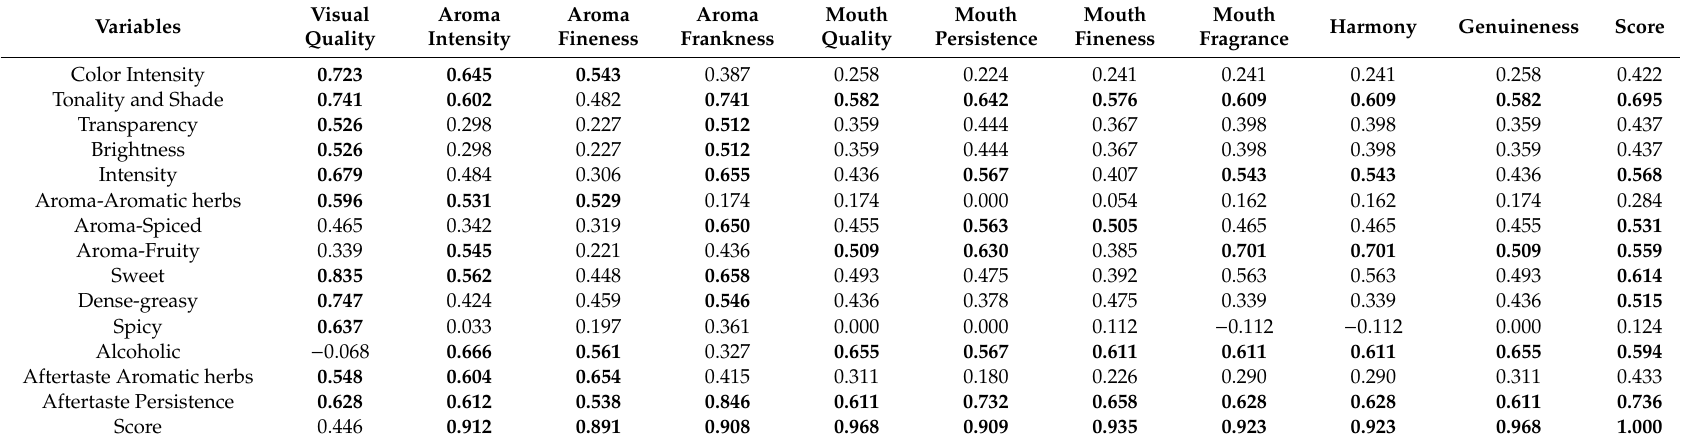
Table 7. Pearson correlation values (R) between descriptive and qualifying parameters in herbal